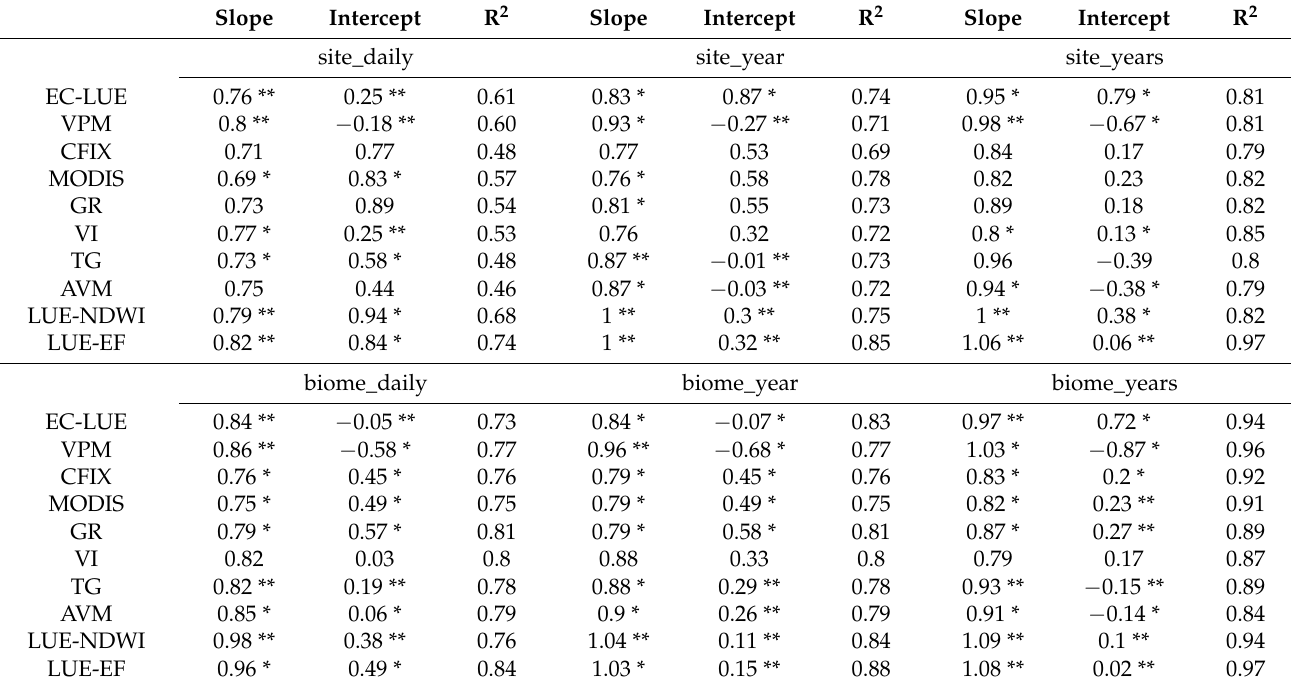
Table 2. The comparison between model GPP and EC-tower GPP at different scales (site scale, biome scale). Slope Intercept R 2 Slope Intercept R 2 Slope Intercept R 2